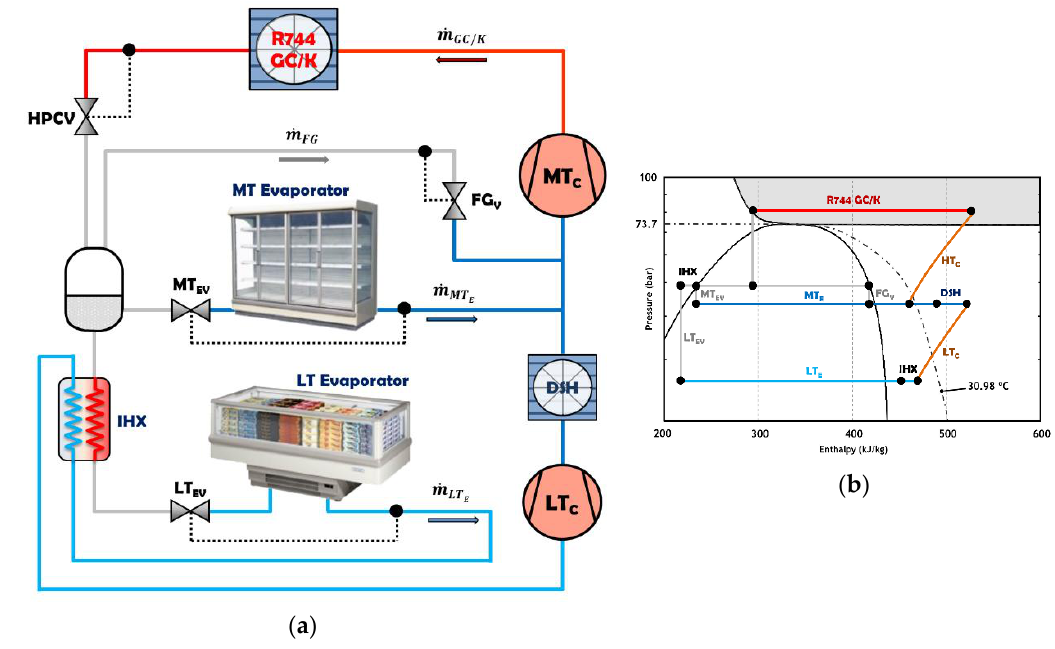
Figure 2. Schematic of a basic booster ( a ) and its p–h diagram ( b ).